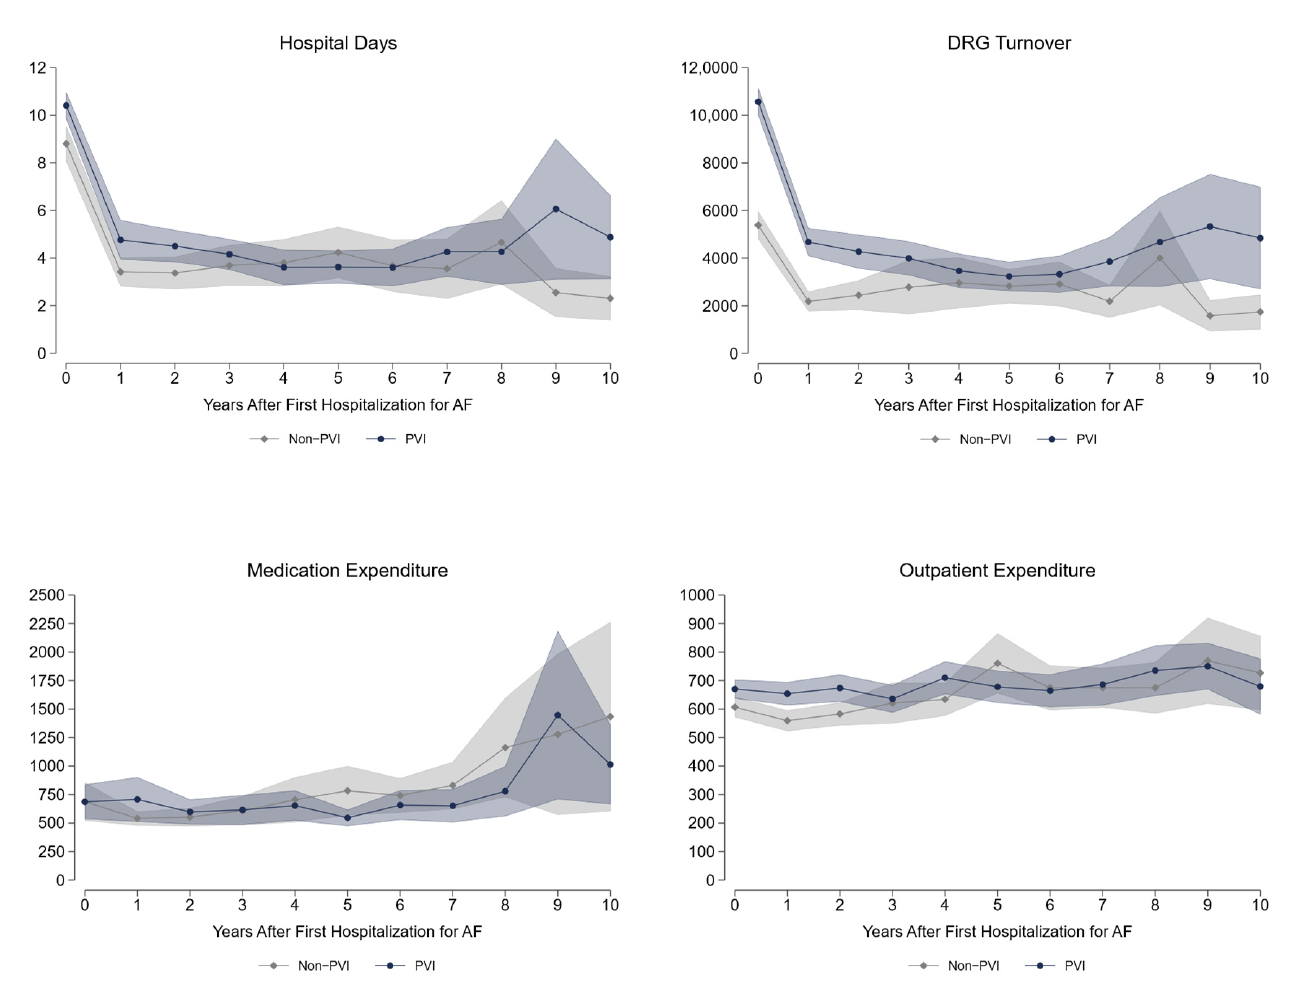
Figure 3. All-cause Mortality. Table 3. Long-term Outcomes ten years after first hospitalization for atrial fibrillation. Ø Non – PVI